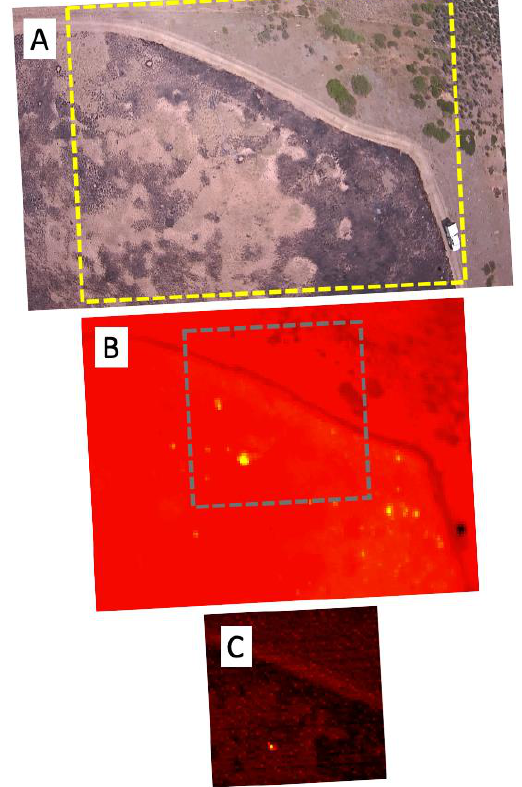
Figure 8. The same area of the prescribed grassland fire as shown in Figure 7, but in the post-active fire phase. No significant smoke is seen in the FLIR visible image ( A ), but the FLIR thermal camera ( B ) and custom SWIR camera ( C ) show distinct evidence of residual hot spots in the burned region. The yellow rectangle in ( A ) defines the area of the corresponding FLIR DUO thermal IR image ( B ), and the grey square in ( B ) defines the area of the approximately coincident SWIR camera image ( C ). The shift in the position of the SWIR camera image relative to the FLIR duo images from Figure 7 to Figure 8 is due to differences in the timing of image acquisition between the two cameras. The 1.6 µm scanner data are not shown because the lower temperatures were not distinguishable from the background created by scattered sunlight.